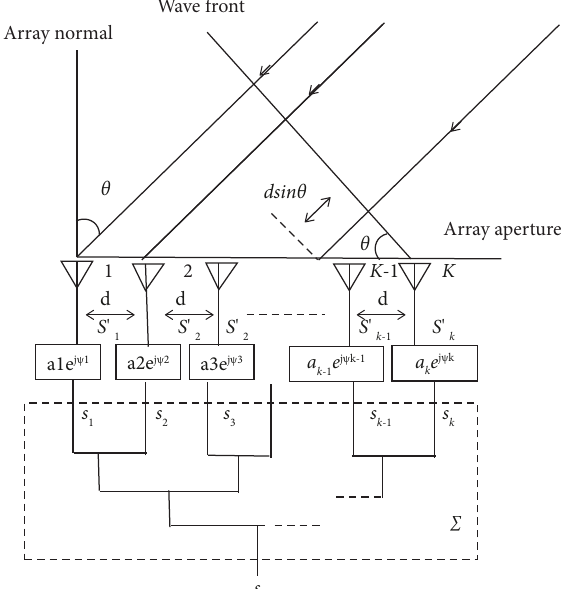
Figure 6: A linear phased array of K radiators[11].